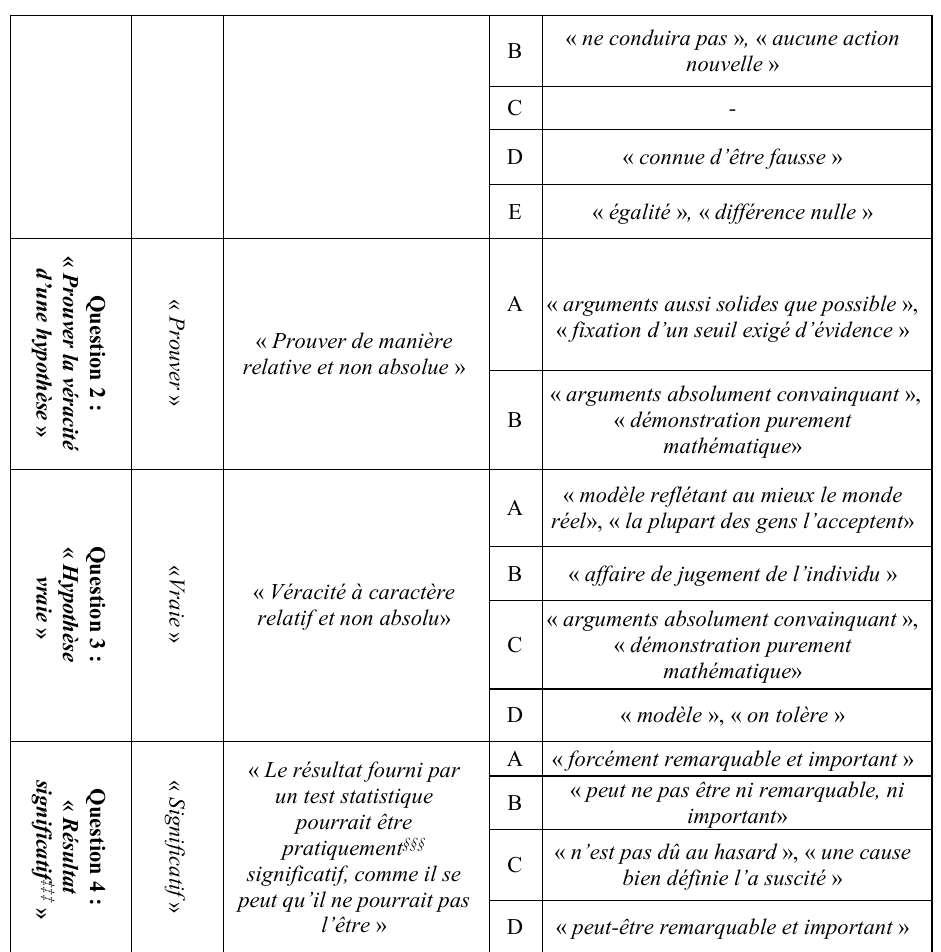
tableau 2 suivant, nous résumons, les différents questions et items du questionnaire, ainsi que les significations et les codages des modalités associées. Ce tableau est, en quelque sorte,